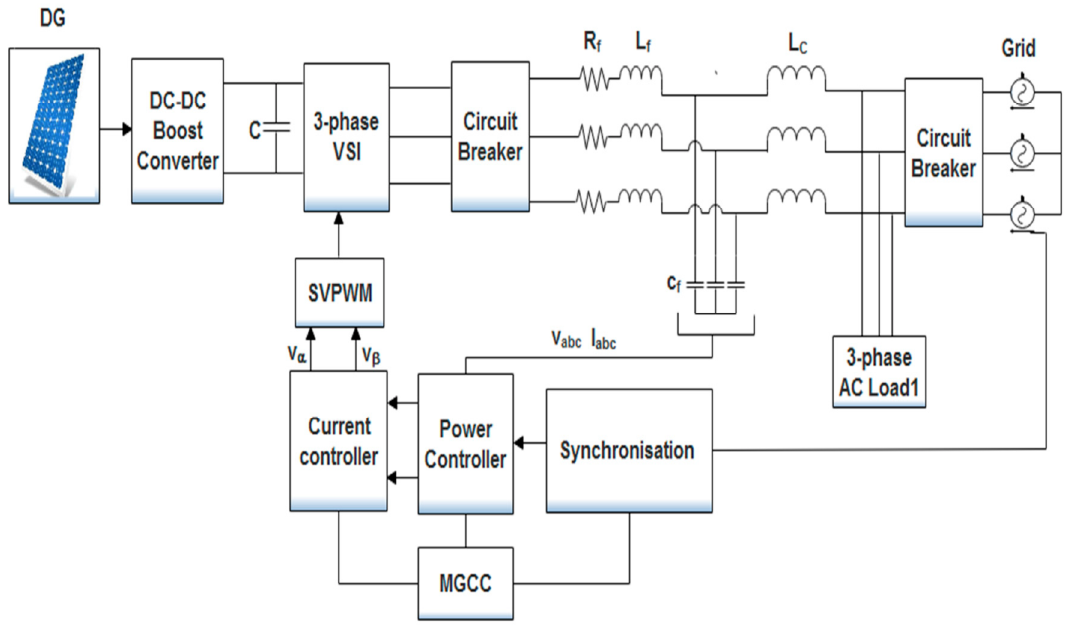
Figure 1. Three-phase Grid-Connected V.S.I. [7]. In Figure 2, the R f , L f , and c f represent the value of resistance, inductance, and capaci- tance of inverter filter respectively while V abc and I abc are three-phase grid voltages and currents respectively. The state-space Equation of the corresponding circuit in abc reference frame is given by [8].